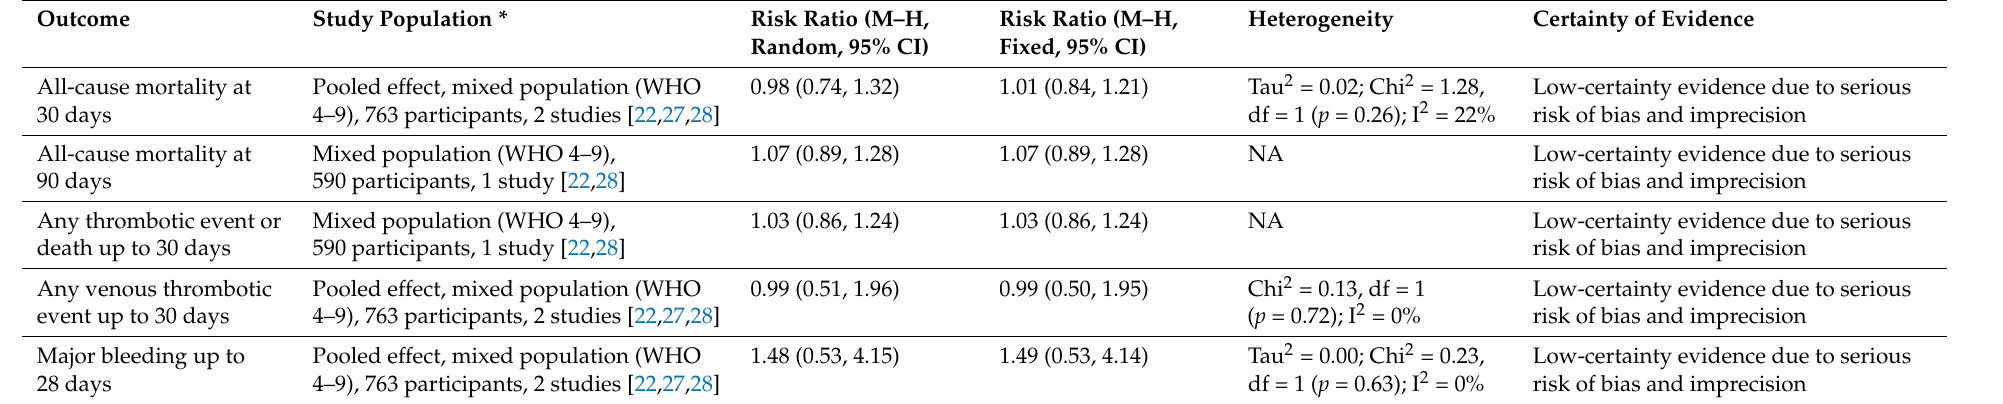
Table 2. Meta-analyses for intermediate-dose anticoagulation versus standard thromboprophylaxis, including certainty of evidence.